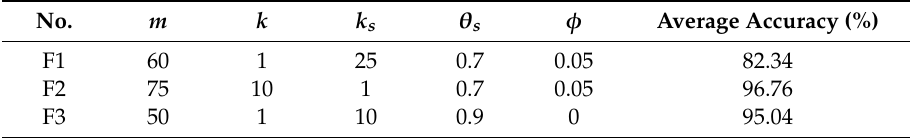
Table 12. Optimum parameters of DNM + competitive swarm optimizer